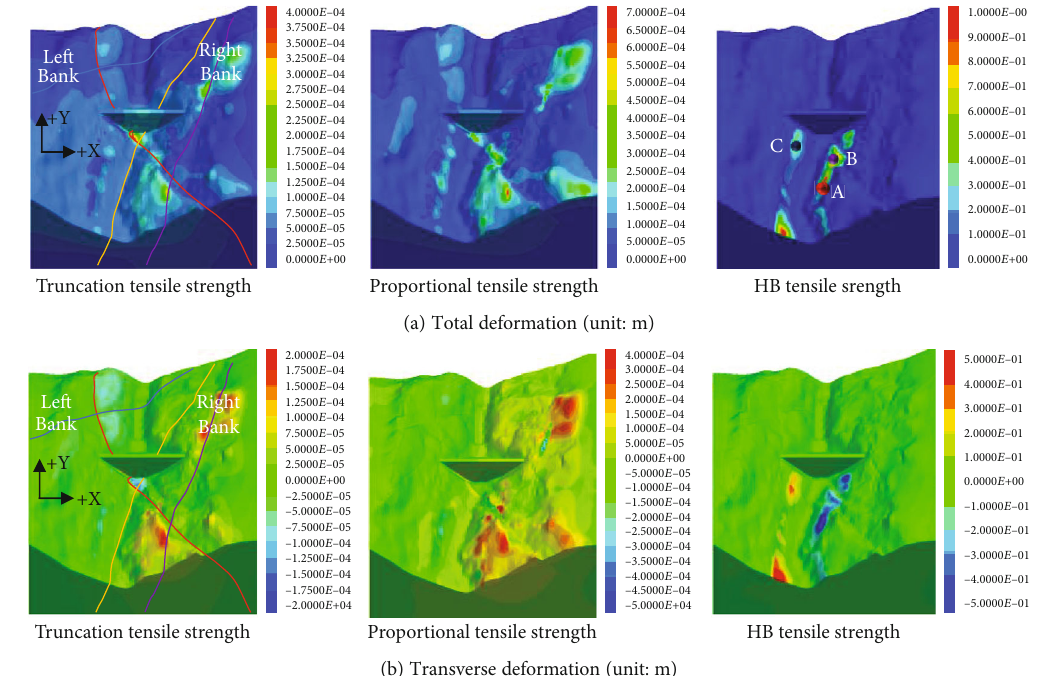
Figure 14: Distribution characteristics of slope deformation at the end of operation period (unit: